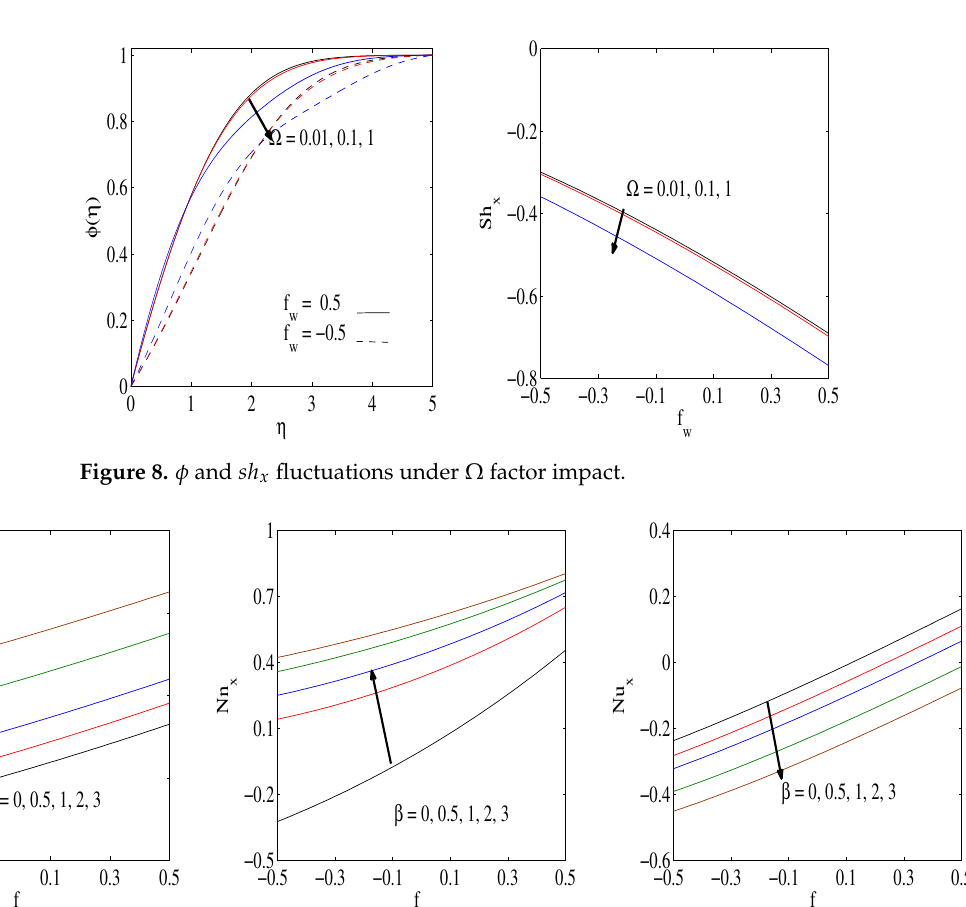
Figure 7. θ fluctuations under the impact of Ec , Q and γ factors.